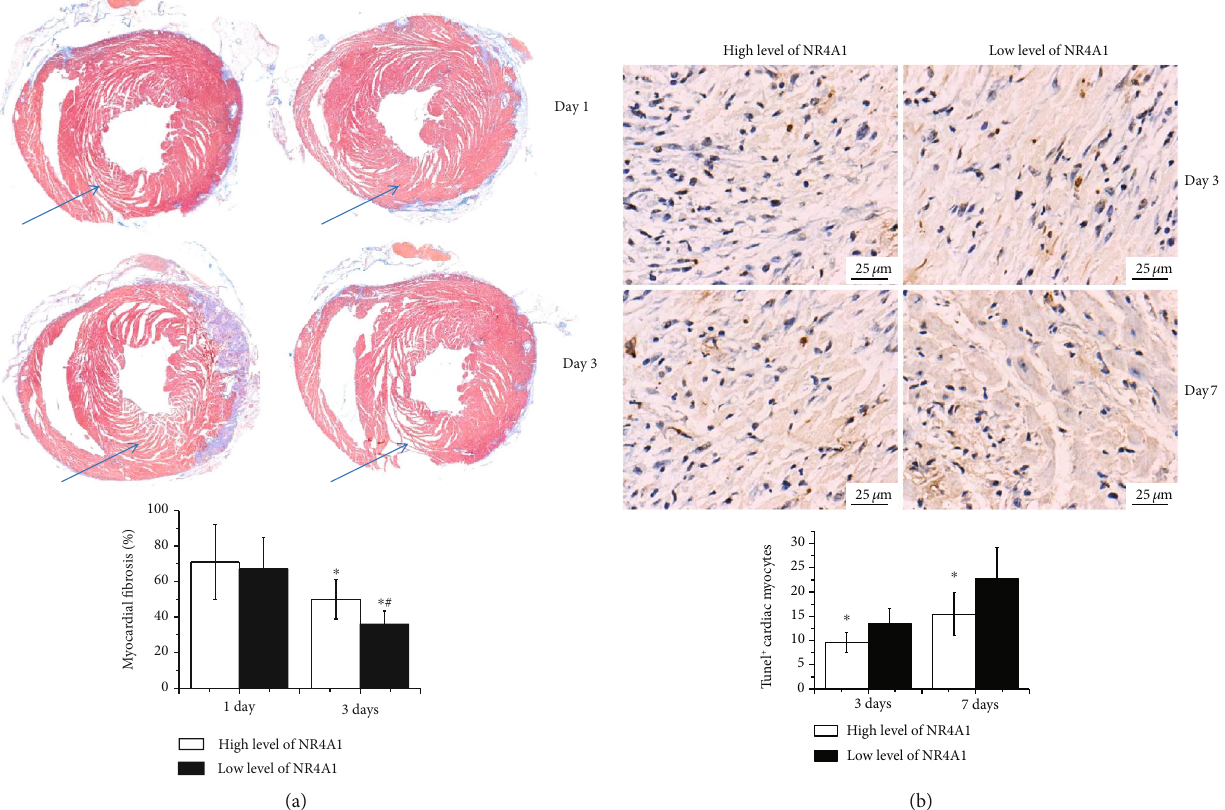
Figure 4: Myocardial remodeling and apoptosis of cardiac myocytes under di ff erent levels of NR4A1. (a) Direct visualization of the lysis of myocardial fi brosis after myocardial infarction through Mason staining at day 1 and day 3. ∗ p < 0 : 05 vs. day 1, # p < 0 : 05 vs. the corresponding low-NR4A1 expression level group; (b) TUNEL + cardiac myocytes at day 3 and day 7 were then separated in two groups as de fi ned above. ∗ p < 0 : 05 vs. the corresponding low-NR4A1 expression level group. Abbreviations: NR4A1: nuclear receptor subfamily 4 group A member 1; TUNEL: terminal deoxynucleotidyl transferase-mediated dUTP nick-end